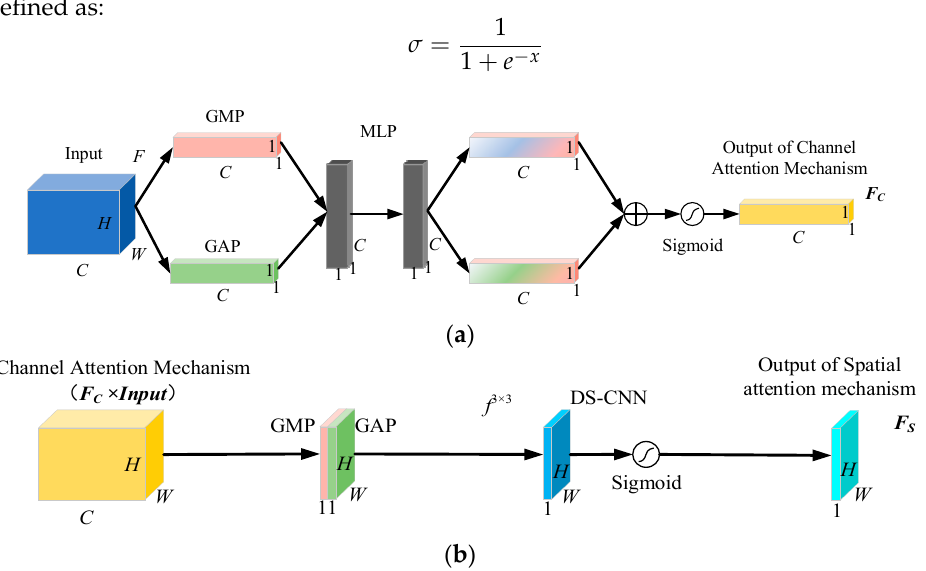
Figure 2. Multi-dimensional attention mechanism CBAM; ( a ) channel attention mechanism; ( b ) spatial attention mechanism.